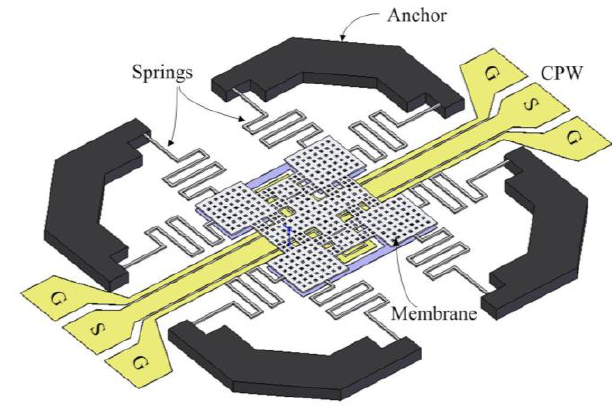
Figure 1. Structure of RF micromachined switch.